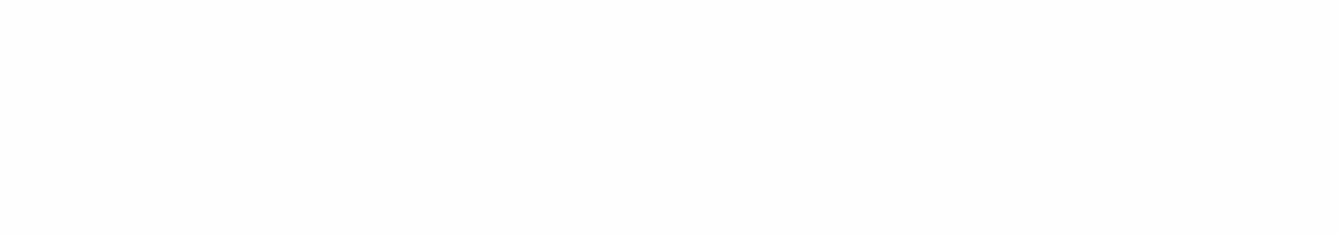
FIGURE 7 Numerical simulation of image processing based on reaction-diffusion equations. Initial half-tone image is shown ofthe picture. Results of simulation different due to divers choice of coupling functions and shifts are: enhancement of thin and thick contrast enhancement, enhancement of lines having different slope and comers of the image, skeleton of the